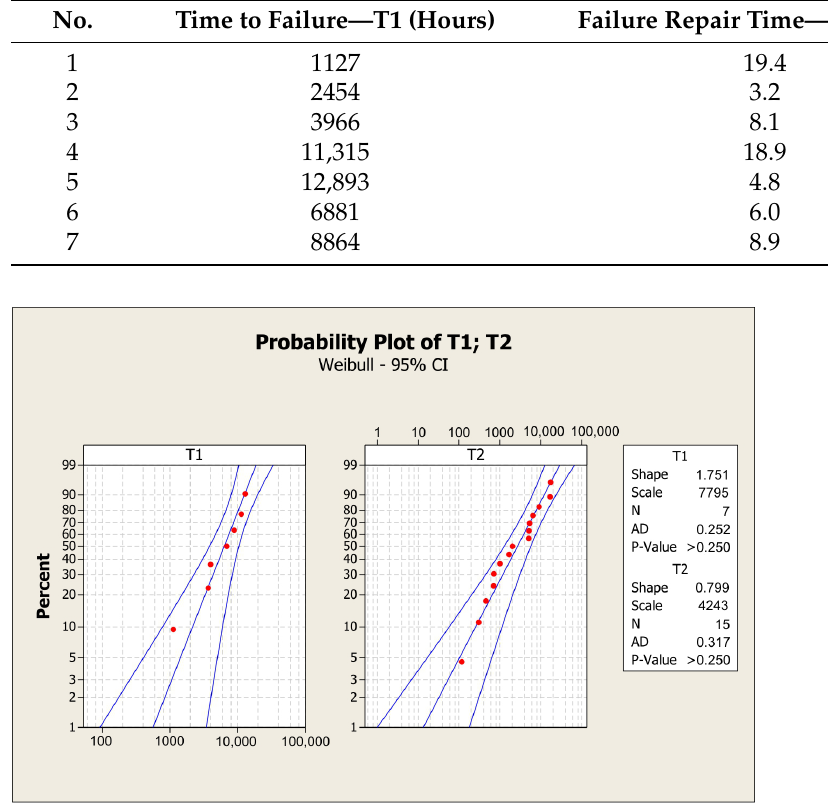
Figure 5. Coal mill feeder T1 time to failure ( left ) and T2 time to damage ( right ) represented by Weibull probabilistic distributions, where red dots are empirical data obtained for each event; N is the number of obtained data; AD is the value of Anderson–Darling statistical test; and the p -value is a measure of how well the data follow the obtained Weibull distribution. Table 2. Empirical data for the coal mill feeder used in the statistical analysis of damages and the time needed for their